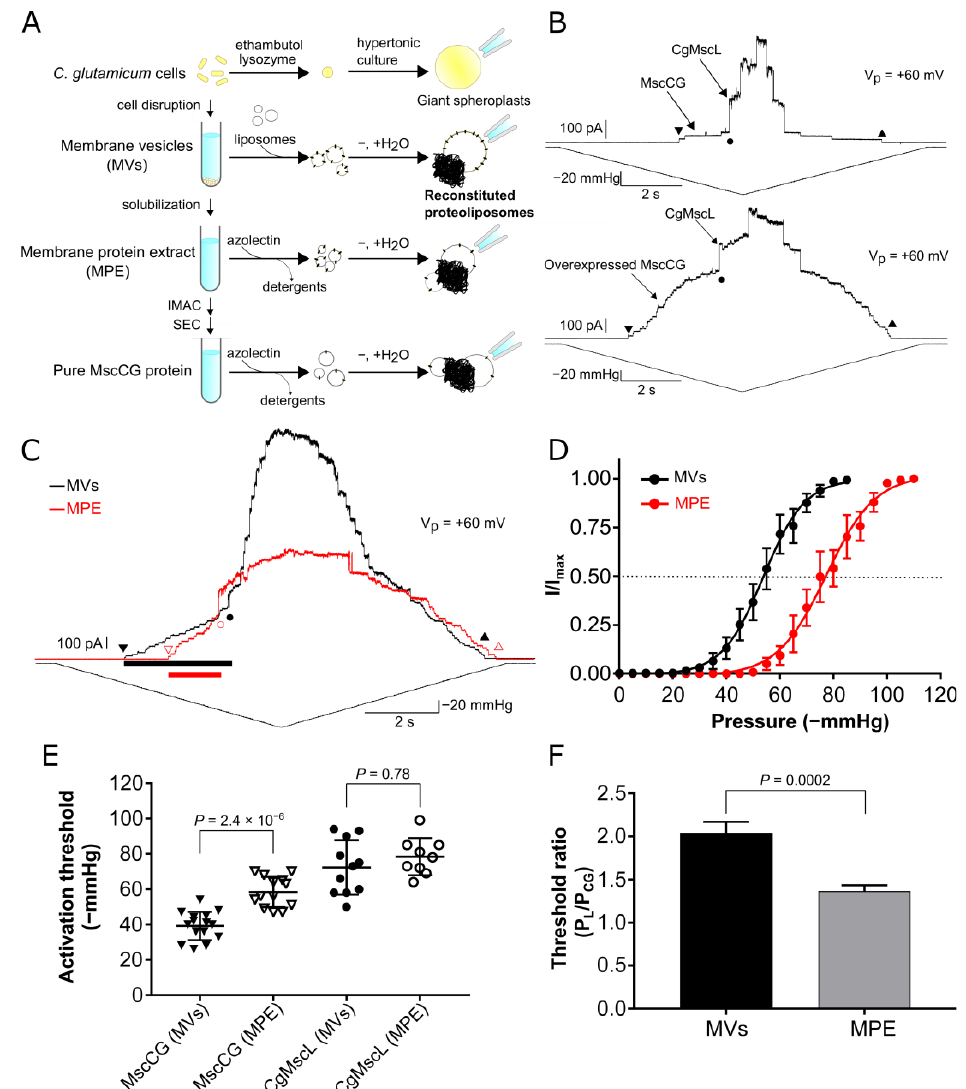
Figure 1. Overexpression of MscCG channels and its mechanosensitivity in liposomes fused with corynebacterial membrane vesicles and liposomes containing membrane protein extract. ( A ) Schematic diagram of liposomal patch-clamp techniques for MscCG mechanosensitive channel purification. ( B ) Current recordings of MscCG and CgMscL in liposomes fused with membrane vesicles. The top trace shows mechanoresponsive currents of MscCG and CgMscL at the native expression level, and bottom trace shows the currents when MscCG was overexpressed. Triangles show the first opening (downward) and the last closing of MscCG (upward), respectively. Circles show the first opening of CgMscL. ( C ) Superimposed traces of mechanosensitive channel currents in liposomes fused with membrane vesicles (MVs) (black) and liposomes containing membrane protein extract (MPE) (red) prepared from MscCG-overexpressing cells. Bars show the distance between the first opening of MscCG (downward closed and open triangles) and CgMscL (closed and open circles). Upward triangles show the last closing of MscCG. ( D ) Boltzmann activation curve of MscCG in liposomes fused with MVs (black) ( n = 7) and liposomes containing MPE (red) ( n = 6). Dashed line shows half activation level. ( E ) First opening threshold of MscCG and CgMscL in liposomes fused with MVs and liposomes containing MPE. ( F ) First opening threshold ratio between CgMscL and MscCG (P L /P CG ) in liposomes fused with MVs and liposomes containing MPE. p -values were calculated by t -test (two-sample assuming unequal variances) to compare between two groups.